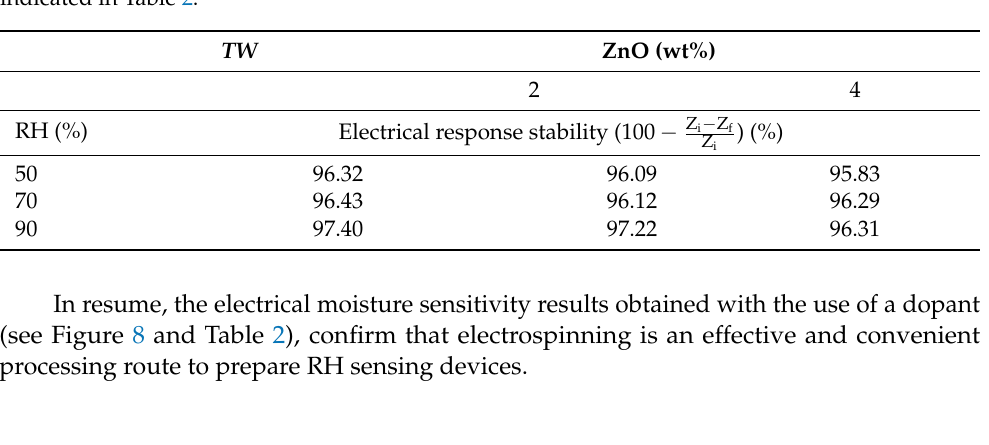
Figure 8. ( a ) Impedance modulus plots comparison of the MOHN obtained samples as a function of RH, at the two selected operating frequencies: ( a ) 750 Hz; ( b ) 1060 Hz. Table 2. Electrical response stability to moisture (at 50, 70 and 90% RH) for the TW and TW − Zn MOHN produced with 2 and 4 wt% of ZnO, respectively. Similarly to the way exactitude is estimated in percentage, the sensing materials electrical response stability is estimated by the formulation indicated in Table